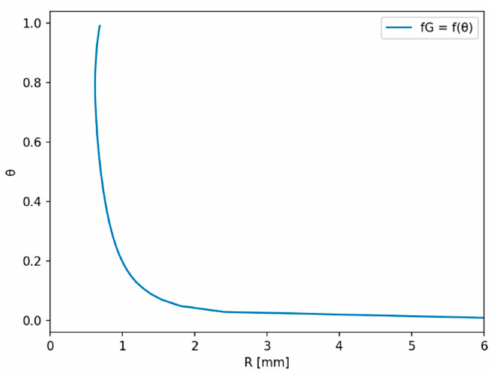
Figure 2. Bubble coverage fraction as a function of bubble mean size.